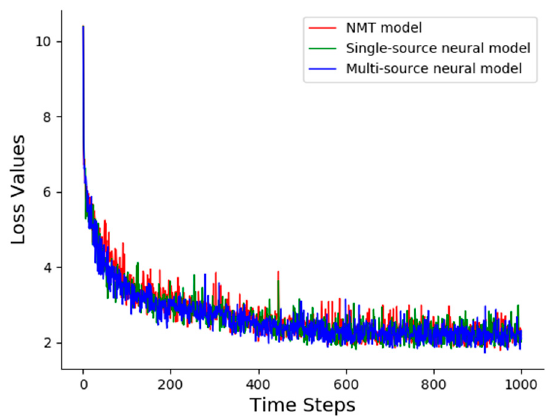
Figure 4. The loss values as a function of the time steps in the di ff erent neural translation models for the Turkish–English machine translation task. 291